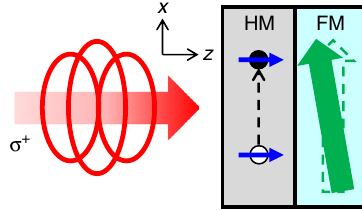
Fig. 1 Schematics for mechanism. A right circularly polarized light ( σ + ) generates a spin-polarized electron ( fi lled circle) and hole (empty circle) excitations in HM (Blue arrows indicate the spin angular momentum). A spin transport from HM to FM induces a damping-like torque on the magnetization of FM (green arrow). A light propagates to the z -direction, and initial magnetization lies along the x